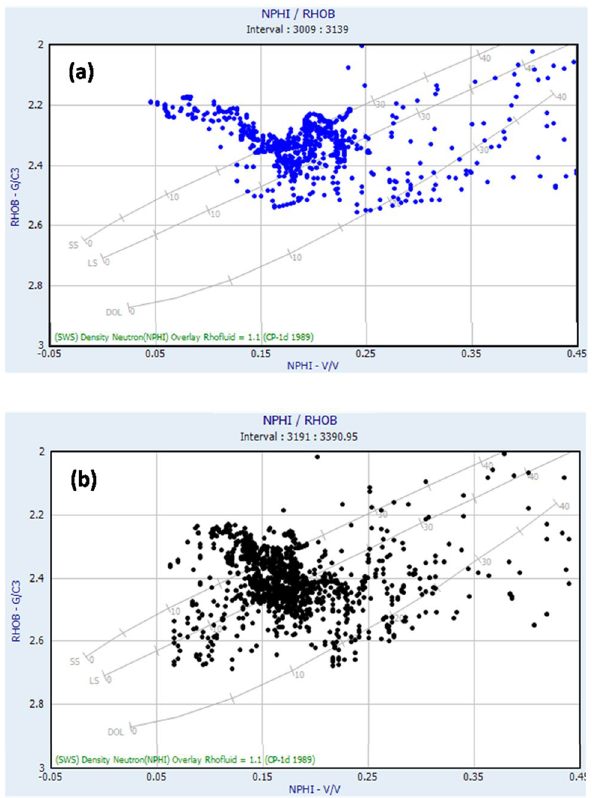
Fig. 16 Neutron–density cross-plots of the studied wells indicating different